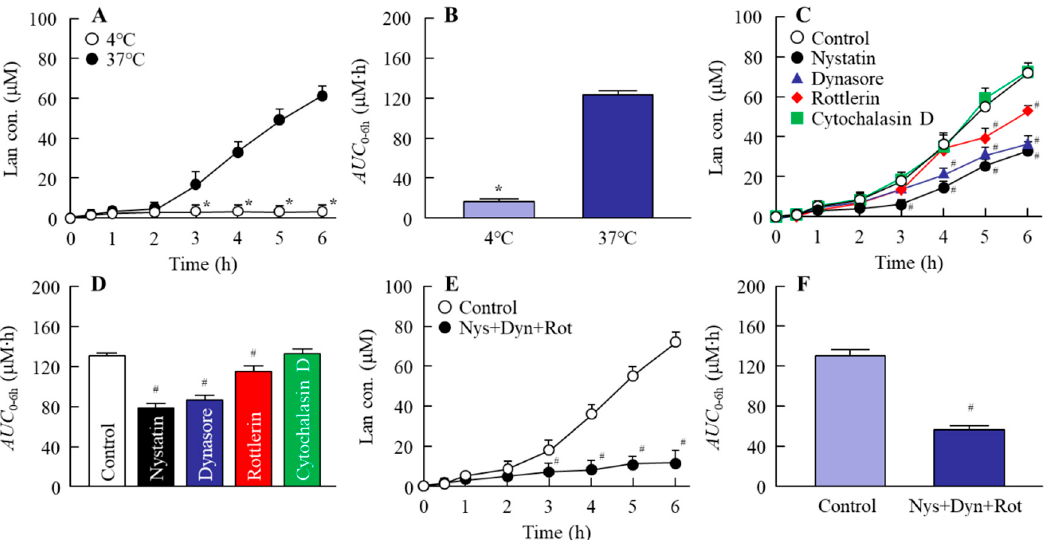
Figure 3. Relationships of energy-dependent endocytosis pathways on transcorneal penetration of LA-NPs / ISG in rabbit corneas. ( A , B ) Penetration profile ( A ) and AUC 0–6h ( B ) of Lan in LA-NPs / ISG at 4 ◦ C and 37 ◦ C. ( C , D ) Penetration profile (C ) and AUC 0–6h ( D ) of Lan in LA-NPs / ISG using the rabbit cornea treated with endocytosis inhibitors. ( E , F ) Penetration profile ( E ) and AUC 0–6h ( F ) of Lan in LA-NPs / ISG using the rabbit cornea multi-treated with nystatin, dynasore, and rottlerin (Nys + Dyn + Rot). Control is the vehicle of corresponding endocytosis inhibitor. n = 5–7. * p < 0.05, vs. 37 ◦ C for each category. # p < 0.05 vs. Control for each category. The AUC 0–6h in the LA-NPs / ISG was decreased under the 4 ◦ C condition. In addition, the multi-treatment of nystatin, dynasore, and rottlerin also inhibited the corneal penetration of Lan in the LA-NPs / ISG.